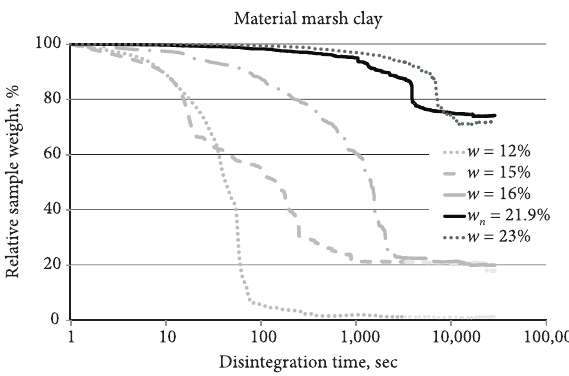
Fig. 8. Disintegration curves (Endell) of marsh clay